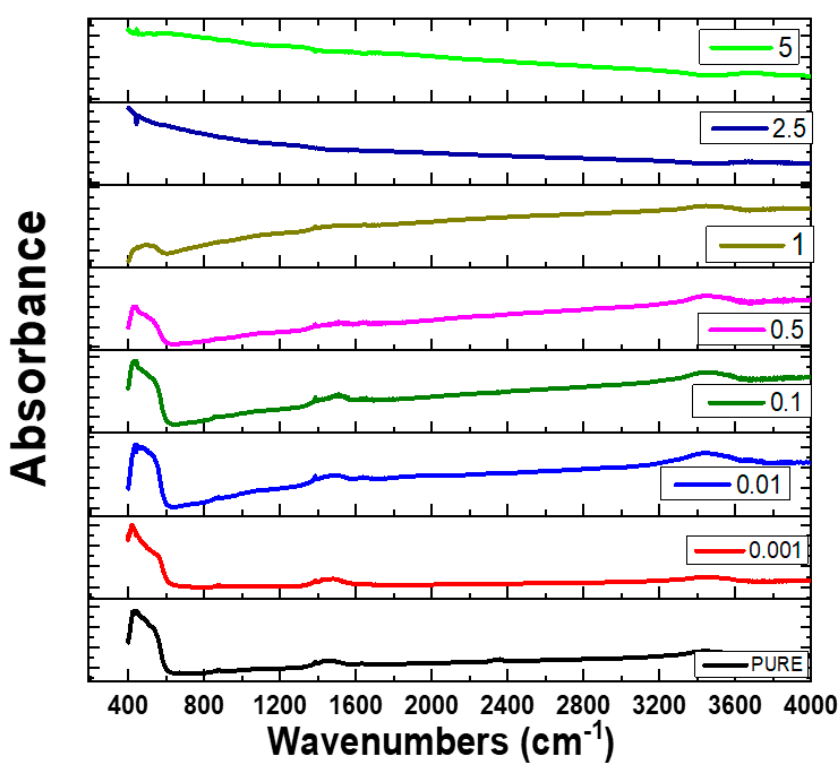
Figure 3. FT-IR spectra of undoped ZnO and Eu 2 O 3 -doped ZnO nanocomposites at different euro- pium (Eu) doping ratios.